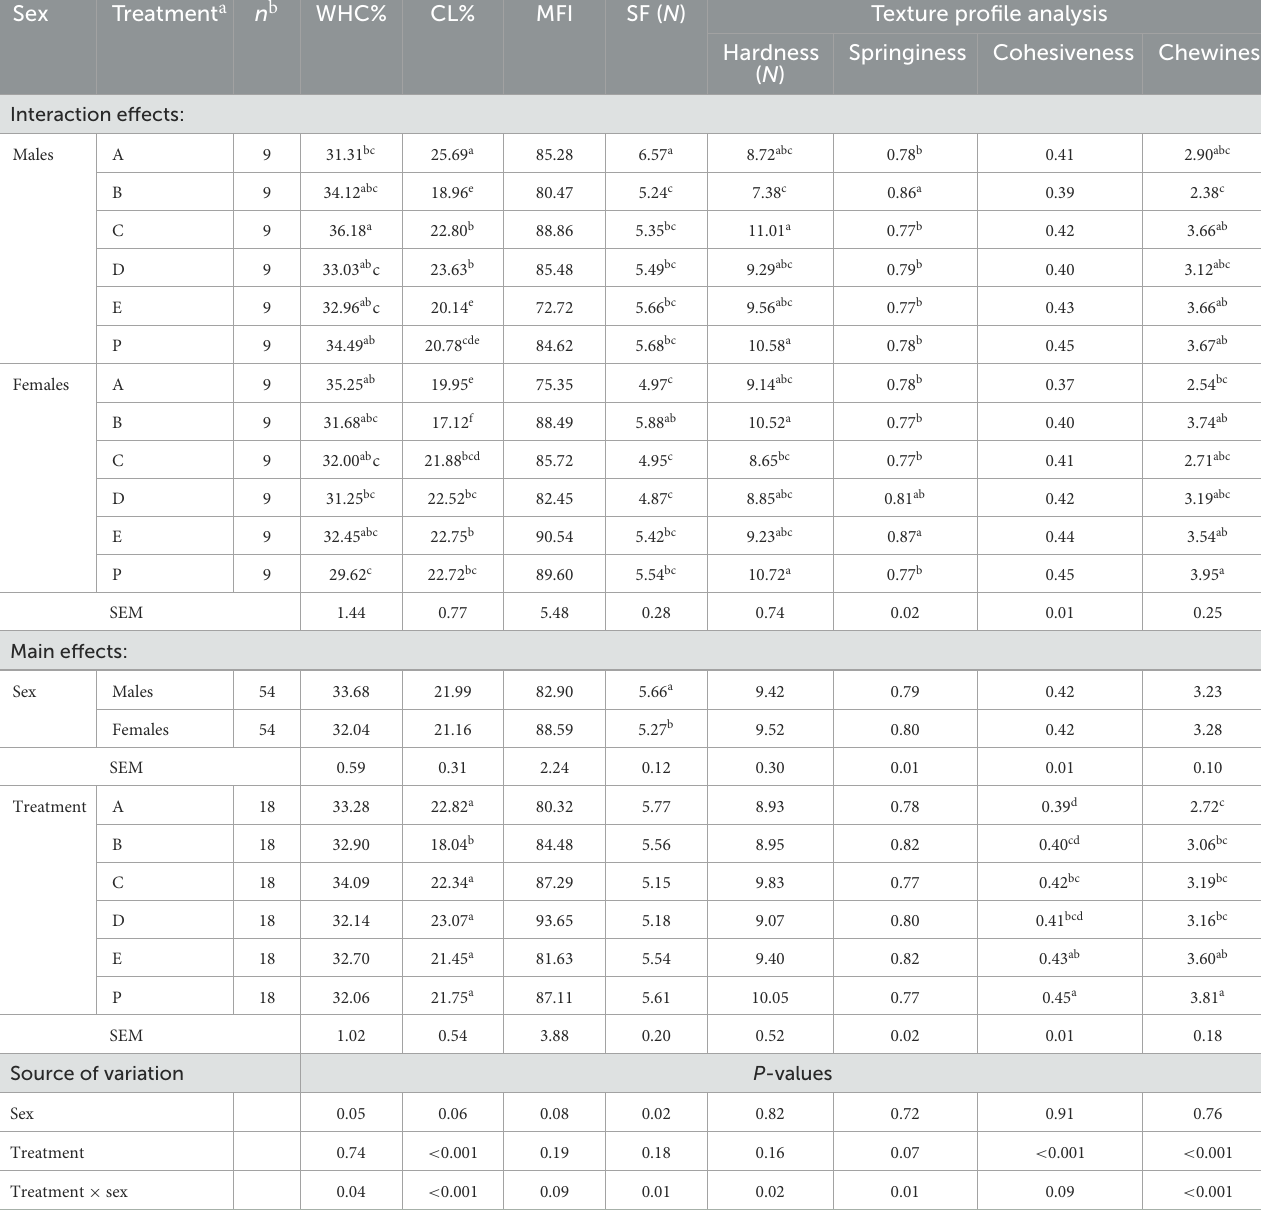
TABLE 5 Effects of adding nano-emulsified plant oil and probiotics to drinking water during different periods besides sex on meat quality of broiler chickens at 35 days of age. Sex Treatment